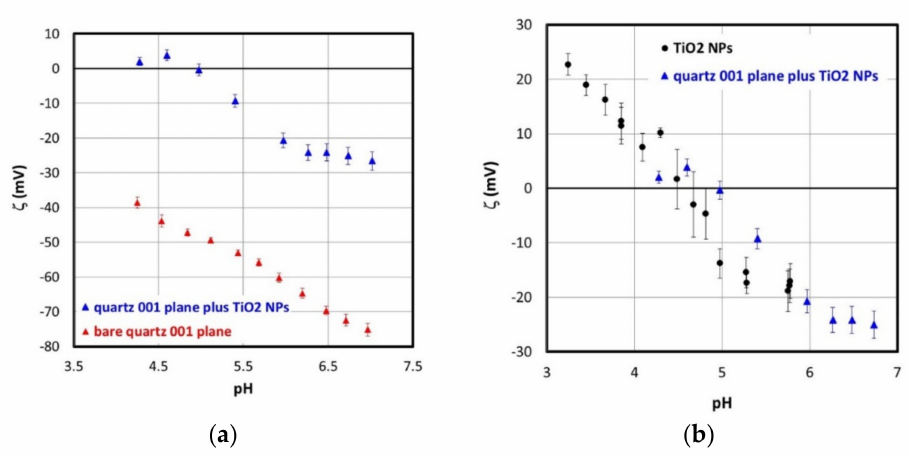
Figure 3. ( a ) Zeta-potential of the quartz (001) plane in the absence and presence of Sample A TiO 2 NPs (total amount 0.125 mg / m 2 ). Background electrolyte is 1 mM NaNO 3 ; 0.5 mL of 1 g / L NP suspension was added to 500 mL of 1 mM NaNO 3 solution at pH around 4. ( b ) Comparison of the zeta-potentials in 1 mM NaNO 3 obtained for the colloidal system from electrophoretic mobilities and those obtained in the quartz (001)—TiO 2 system using zeta-potential from streaming current measurements at flat